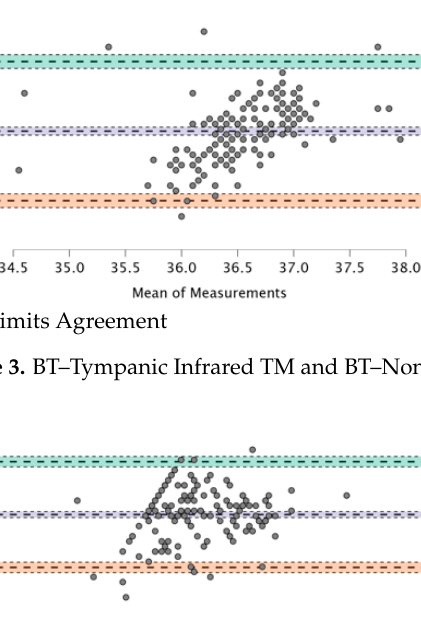
Figure 2. BT–Non-Contact Tympanic Infrared TM and BT–Axillar Gallium TM.